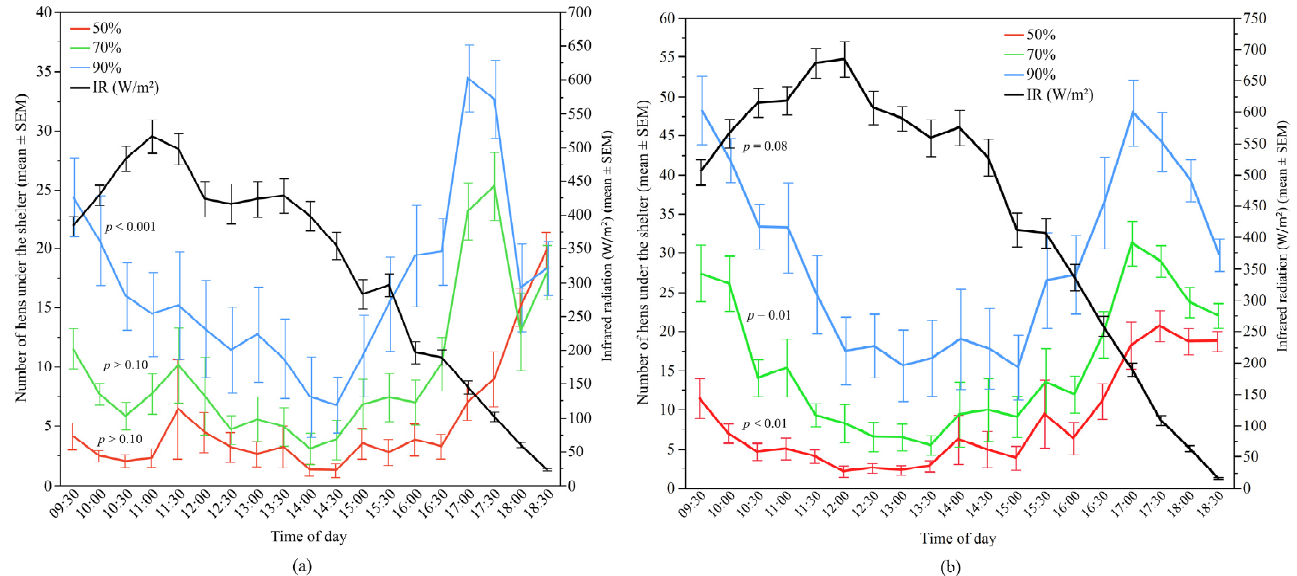
Figure 10. The mean (±SEM) number of hens under the different UV-filtering shelters (50%, 70%, and 90%) and the mean (±SEM) infrared radiation (IR) throughout the day: ( a ) Flock-A; ( b ) Flock-B ( p > 0.10 indicates the variable had no significant effect and was removed from final model). Note the different Y-axis scales between Flock-A and Flock-B. Raw values are presented with analyses conducted on transformed